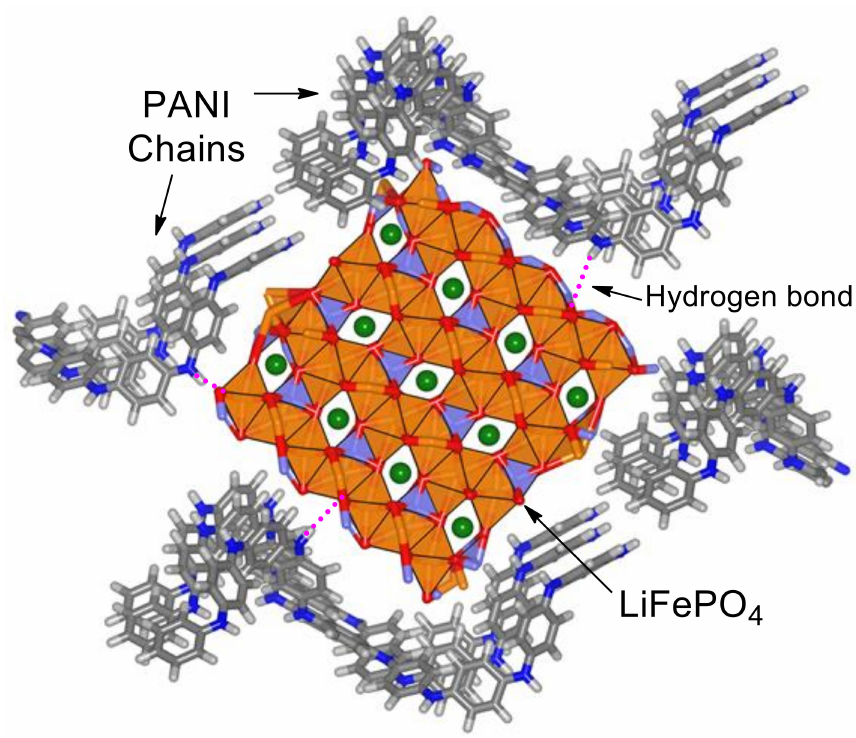
Figure 21. Qualitative structure for LiFePO 4